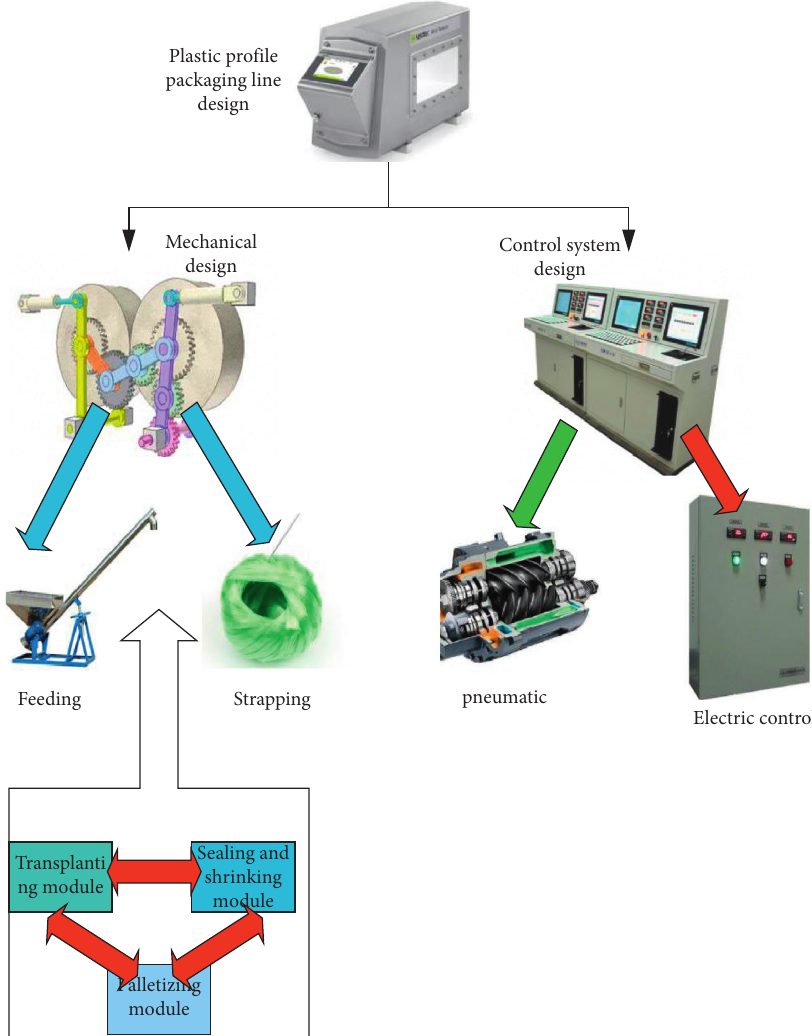
Figure 1: Plastic profile line diagram of the overall